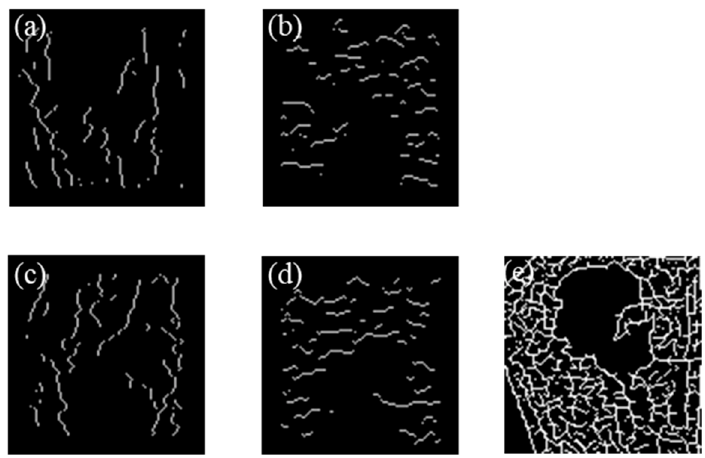
Figure 5. Segmentation results of the operator in different directions, ( a – d ) are the results of setting the direction θ to 0, π ⁄ 2, π , 3 π ⁄ 2, ( e ) is the fusion of the segmentation results in four